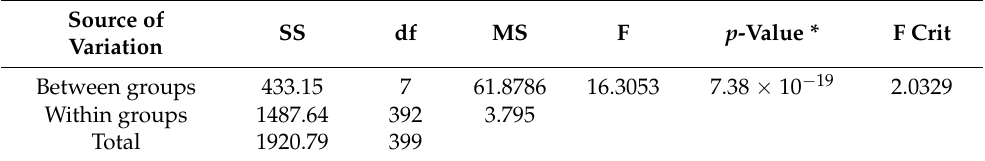
Table 5. Source of variation ANOVA. Source